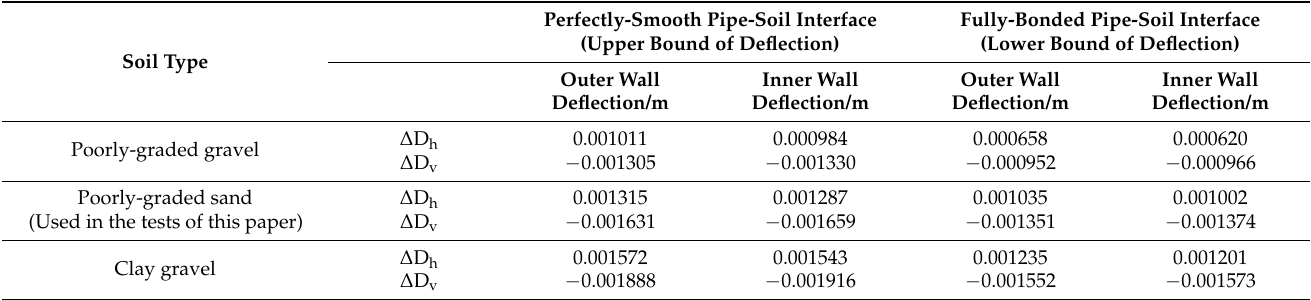
Table 6. The deflection of the buried HDPE pipe in different backfill materials under 420kPa vertical